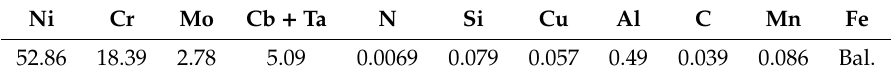
Table 6. Test data and strain measurements. Table 5. Inconel 718 chemical composition as received.